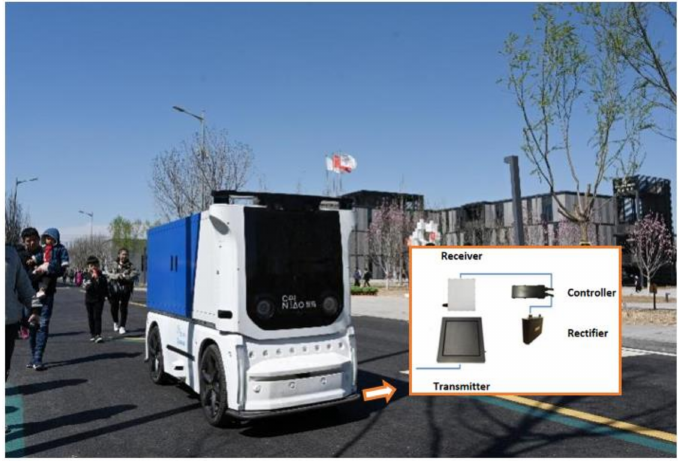
Figure 1. Electric logistics